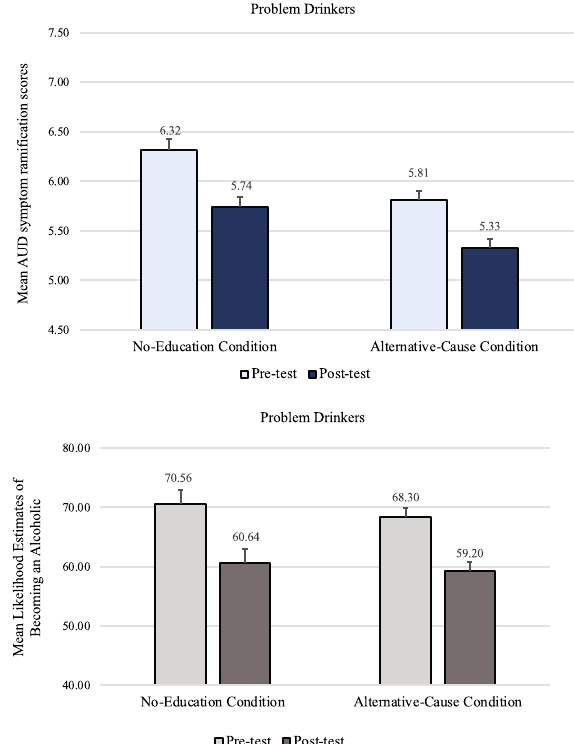
Figure 5. Problem-drinkers’ mean AUD symptom ramification scores and mean likelihood estimates of becoming an alcoholic in Study 2, by condition at pre-test and post-test. Error bars represent SEM pairedDiff